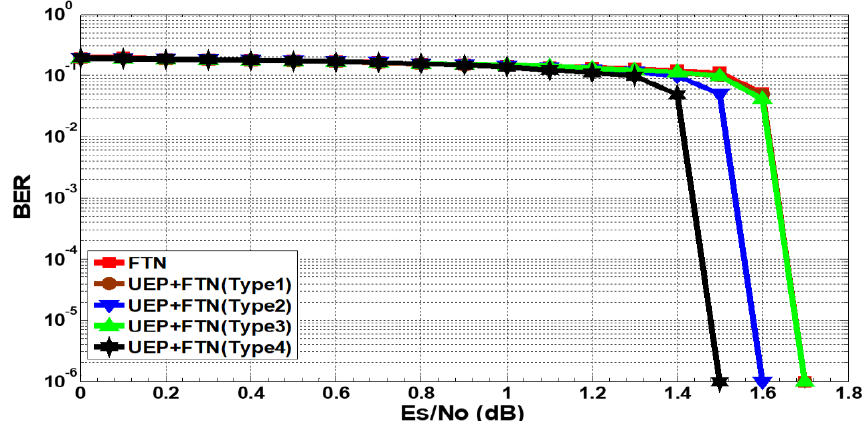
Figure 8. The performance of the FTN method based on the UEP algorithm ( 𝜏 ′ = 20% ).